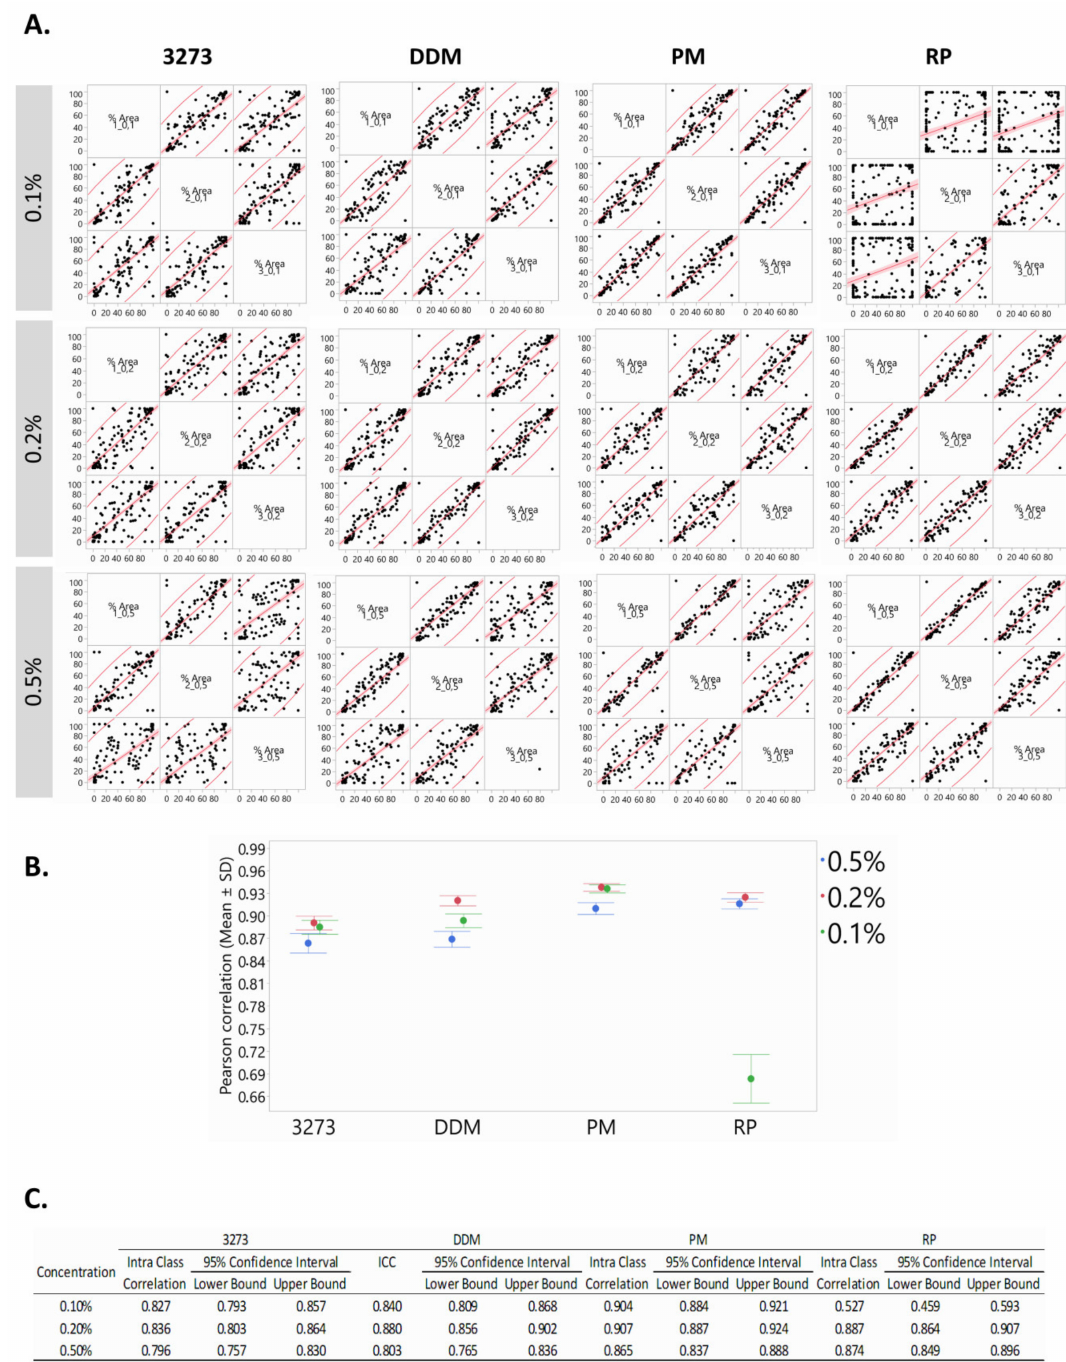
Figure 4. Reproducibility evaluation. ( A ) All biological replicates in each condition were compared and correlated two by two using Pearson’s correlation. ( B ) Plot of means of correlation coe ffi cients calculated for each detergent at the 3 tested concentrations: 0.1%, 0.2%, and 0.5% (mean ± SD). ( C ) The intraclass correlation coe ffi cient (ICC) was calculated per condition to further assess the consistency of each method, which proved the reliability of RP at